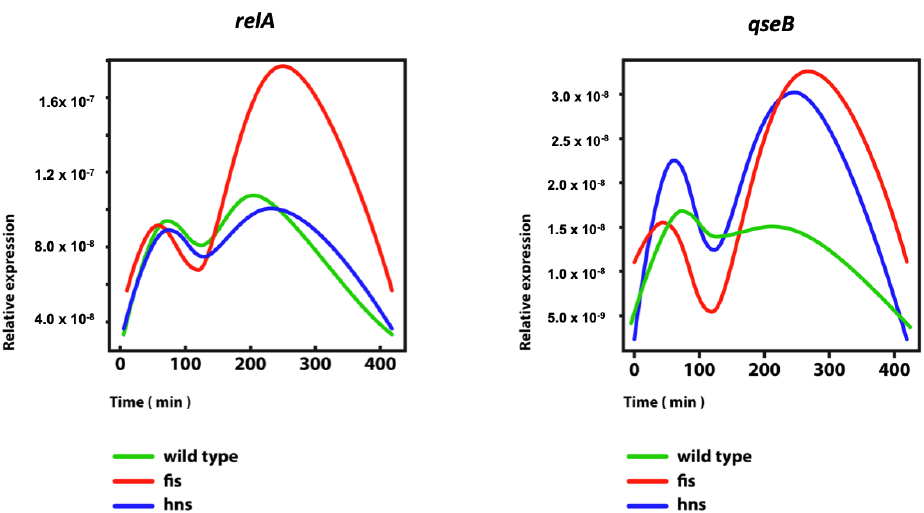
Figure 1. Regulation of the gene expression of ppGpp synthetase relA and the quorum-sensing regulator qseB in growing wild-type E. coli cells and mutant derivatives lacking the chromatin-shaping proteins FIS and H-NS. Abscissa—time (min) after inoculation of stationary cells in fresh medium. The time intervals 0–100’, 100–300’, and >300’ contain approximately the early (lag), middle (exponential), and stationary phases, respectively [12]. Ordinate—relative expression in arbitrary units. The color of the curves indicates the genetic background. The Escherichia coli CSH50 overnight cultures were inoculated at an initial OD600 of 0.1 in rich double-yeast-tryptone (dYT) medium and grown in a fermenter under constant pH 7.4 and high aeration (5 L air per min) at 37 °C for 7 h (420 min). Samples for RNA-seq were taken at intervals after inoculation as indicated and immediately dissolved in ice-cold ethanol – phenol (5% phenol) solution to prevent mRNA degradation. RNA was extracted using the RNeasy Mini kit (Qiagen, Hilden, Germany) and treated with Turbo DNase (Life Technologies, Carlsbad, CA, USA). Subsequent rRNA depletion was carried out using the MicrobExpress kit (Life Technologies), and 0.5 μg of enriched mRNA of each sample was subjected to RNA-seq (Illumina HiSeq 2000, Illumina, San Diego, CA, USA). In this figure and Figures 2 and 3 time-resolved RNA-seq data of E. coli wild-type, fis, and hns mutant strains can be accessed via GSE65244 (NCBI Geo database).